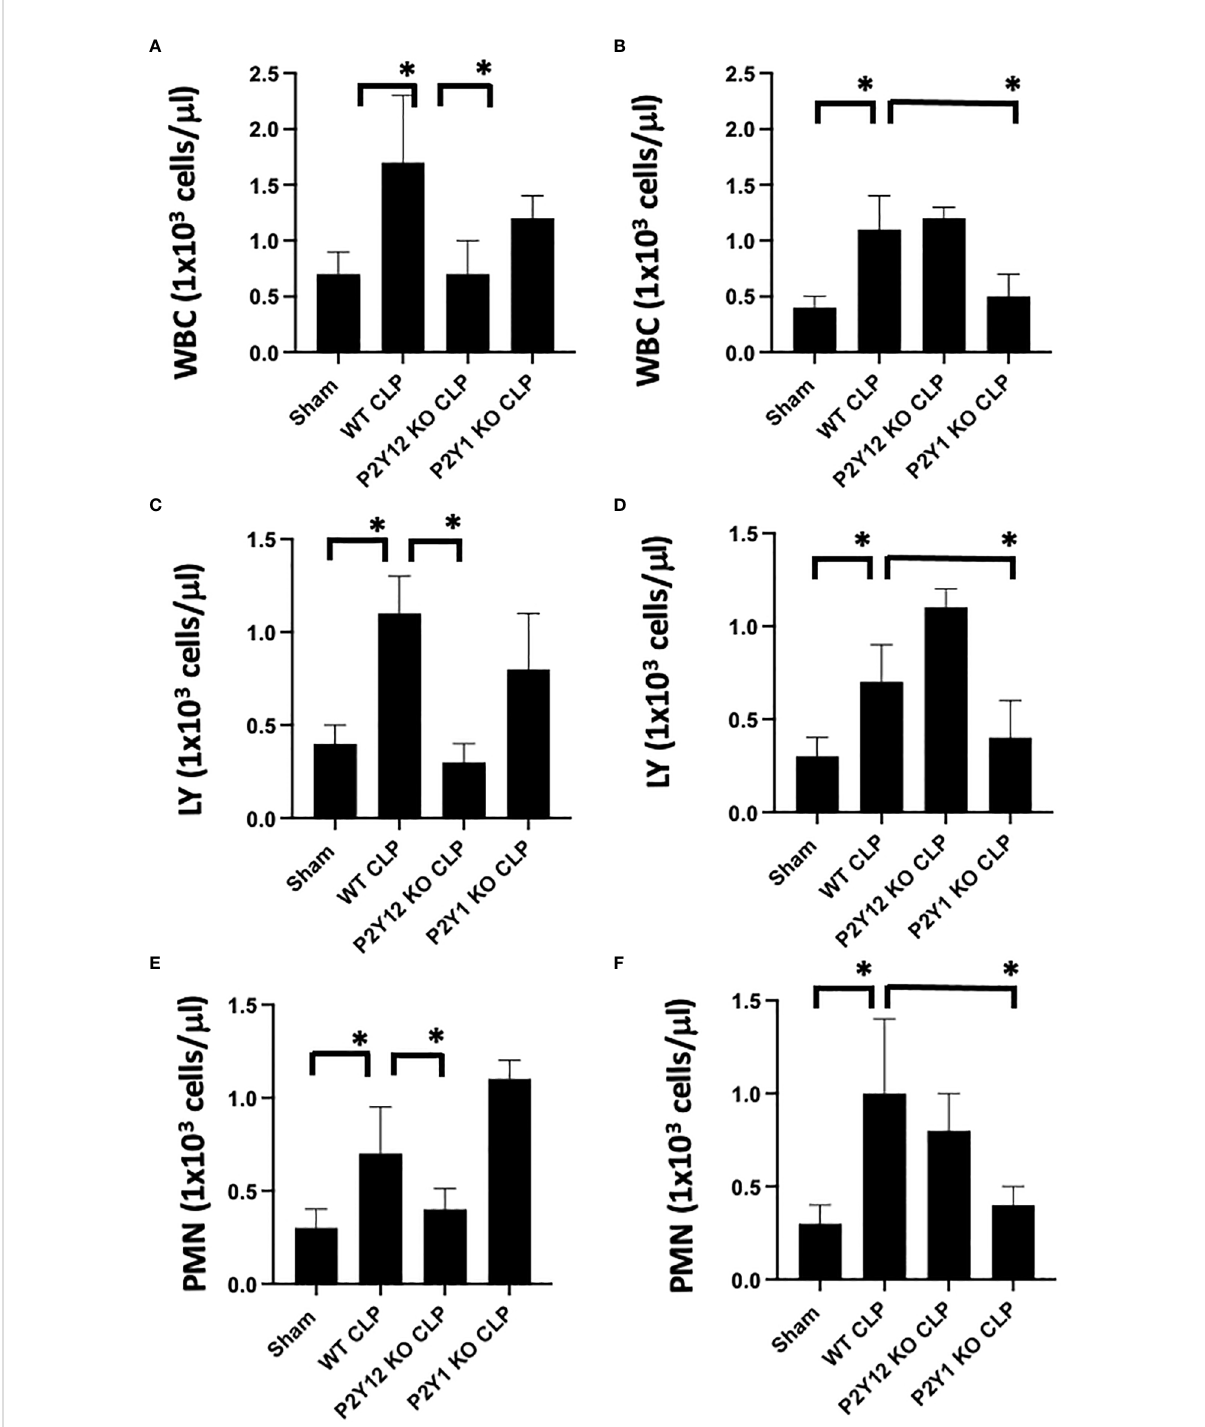
FIGURE 1 In fl ammation-induced elevation in circulating white blood cell counts is decreased in male P2Y 12 and female P2Y 1 KO mice. Blood samples were collected by cardiac puncture in 3.8% sodium citrate (10:1), and hematology studies were performed. Graphs show counts of White blood cells (WBC, A, B ) lymphocytes (LY; C, D ), and neutrophils (PMN; E, F ). Sham and CLP in wild-type (WT) and P2Y 12 KO and P2Y 1 mice of male (A, C E) and female (B, D, F) mice. Values are expressed as 1x10 3 cells/ m L, mean ± S.E.M. n = 5). (*P < 0.05). No differences between WT, P2Y 12 KO, and P2Y 1 KO sham were noted in both male and female mice (data not